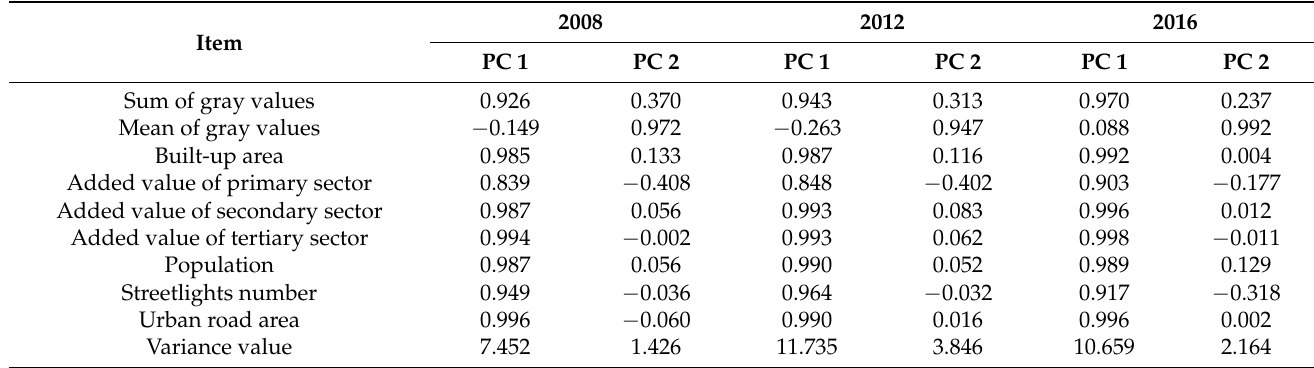
Table 4. Component matrix in 2008, 2012, and